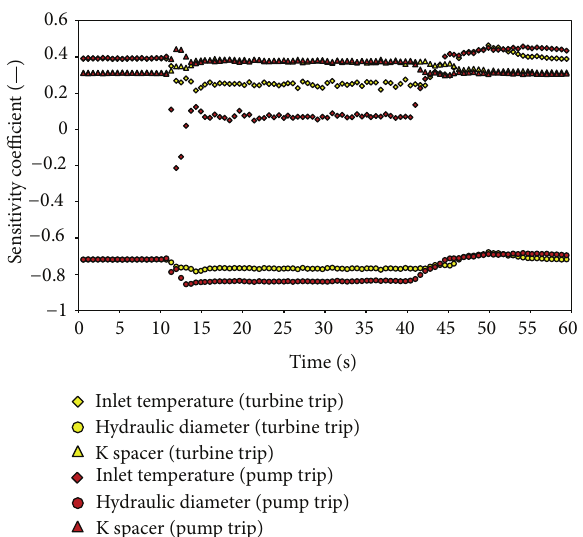
Figure 5: Sensitivity coefficients related to the pressure drop for the turbine trip (yellow symbols) and the recirculation pump trip (red symbols) with